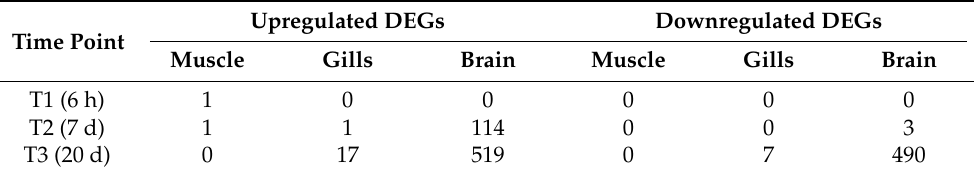
Table 1. Number of DEGs observed across all comparisons in the heat stress experiment.